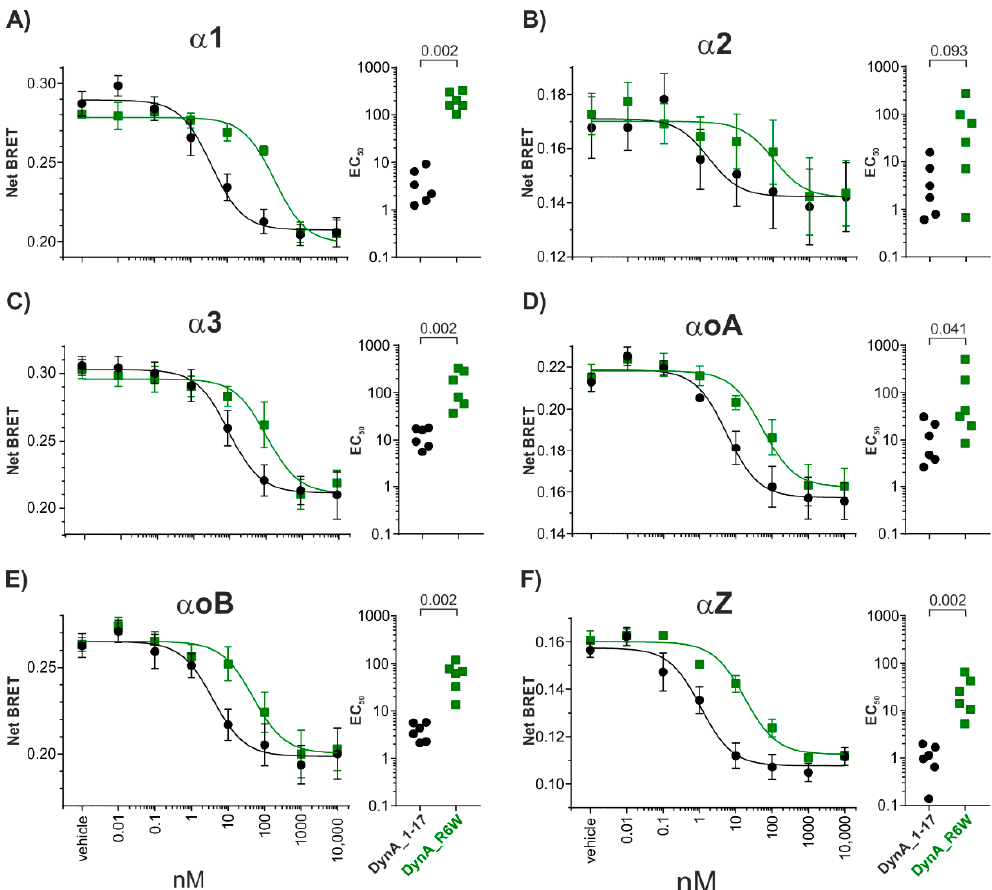
Figure 2. DynA_1-17 and DynA_R6W peptides transducerome at hKOR. ( A – F ) Left: Dose response curves of TRUPATH (BRET assay) in HEK293 cells transiently transfected with hKOR and the different G α subunits. ( A – F ) Right: Summary showing the magnitude of the change in EC 50 induced by DynA_1-17 and DynA_R6W peptides for each G α subunit. Data are mean ± SEM. Mann–Whitney test, p -values are indicated in the figure.